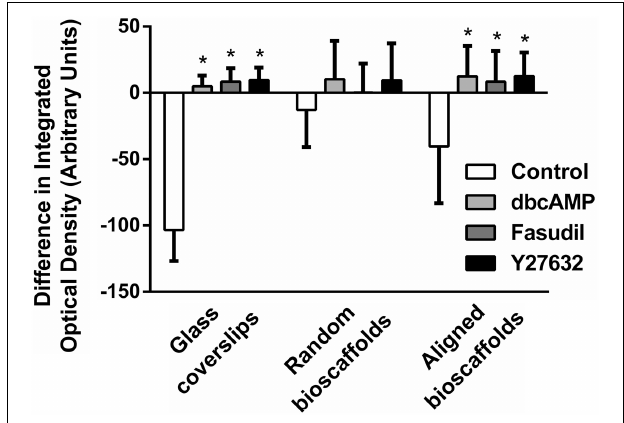
FIGURE 3 | Image analysis of difference in integrated density for F-/G- actin ratio. Astrocytes were treated for 72h with vehicle (Control),